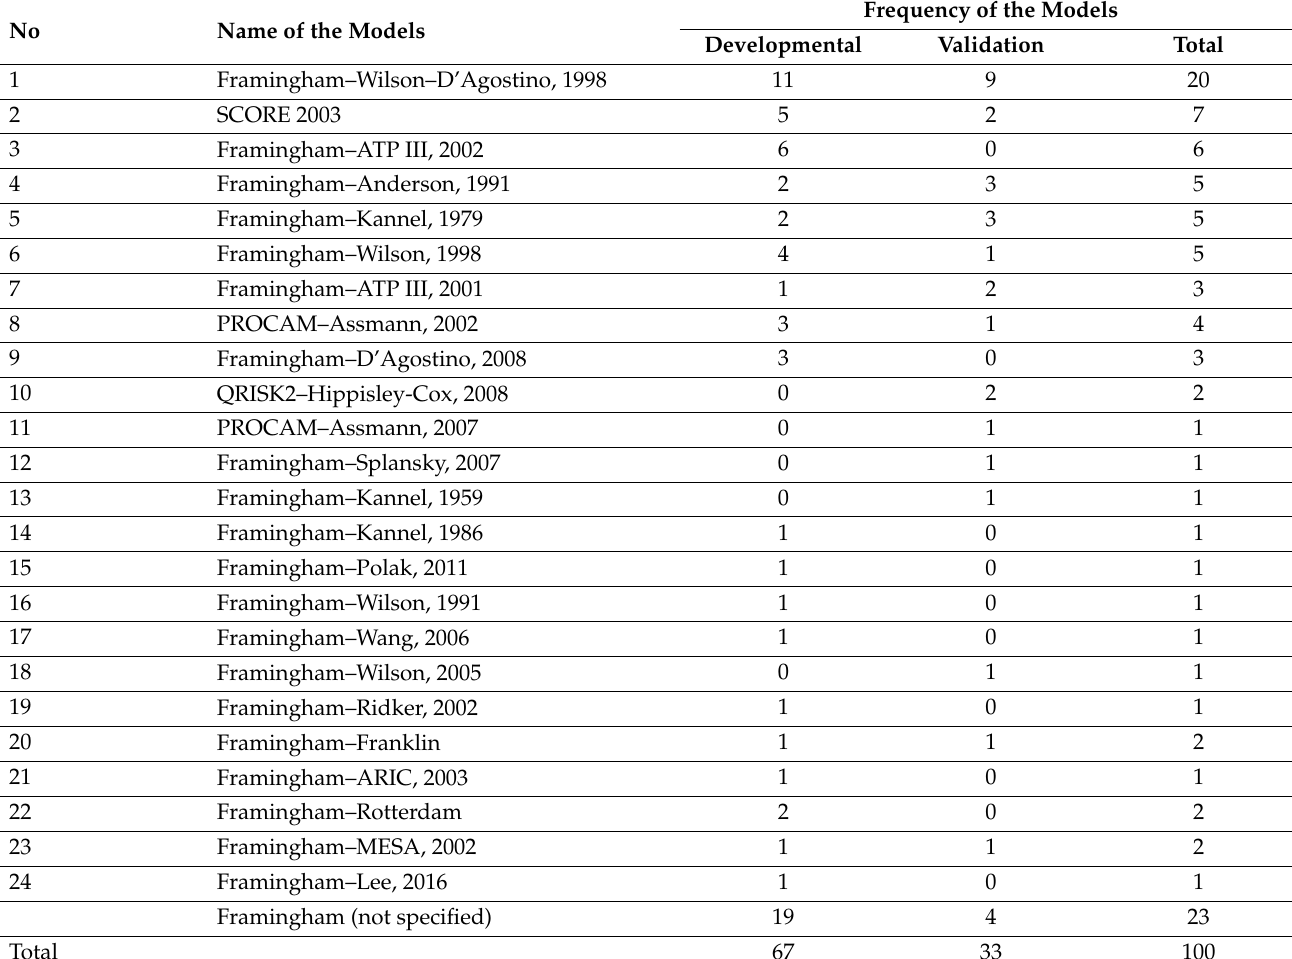
Table 1. List of the models that were developed and validated for predicting coronary heart diseases in the general